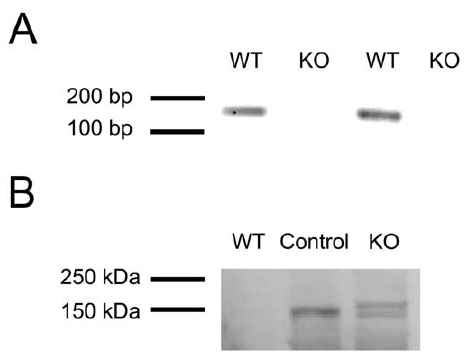
Figure 2. Confirmation of loss of WT mRNA and fusion protein expression in mutant hippocampus. ( A ) The WT mice, in contrast to the homozygous Btbd9 mutant mice, produced a strong RT-PCR fragment of the Btbd9 gene. ( B ) The Btbd9 protein is expressed in the hippocampus of adult mice. Antibody against b -galactosidase detected b -geo fusion proteins from both the Btbd9 mutant and a positive control mouse that had a gene trap insertion in a different gene, while no band was observed in the WT control.